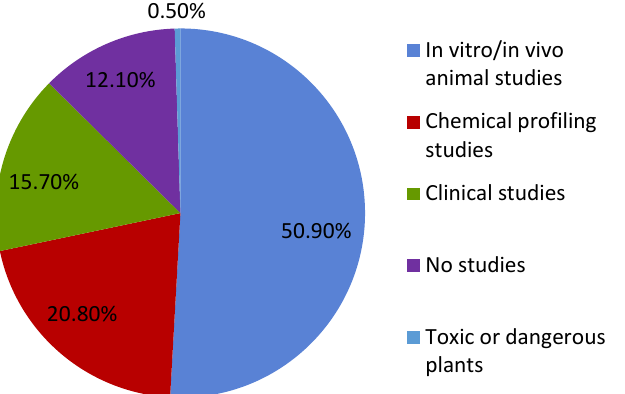
Figure 4. Status of studies on medicinal plants which investigated extracts and thus mixtures of substances and not pure substances according to [18]. 2. Green Manufacturing for Herbal Remedies